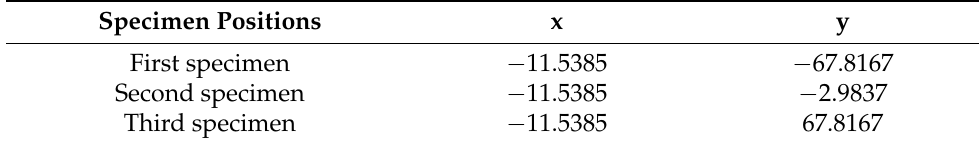
Table 5. Specimen coordinates of Slicing